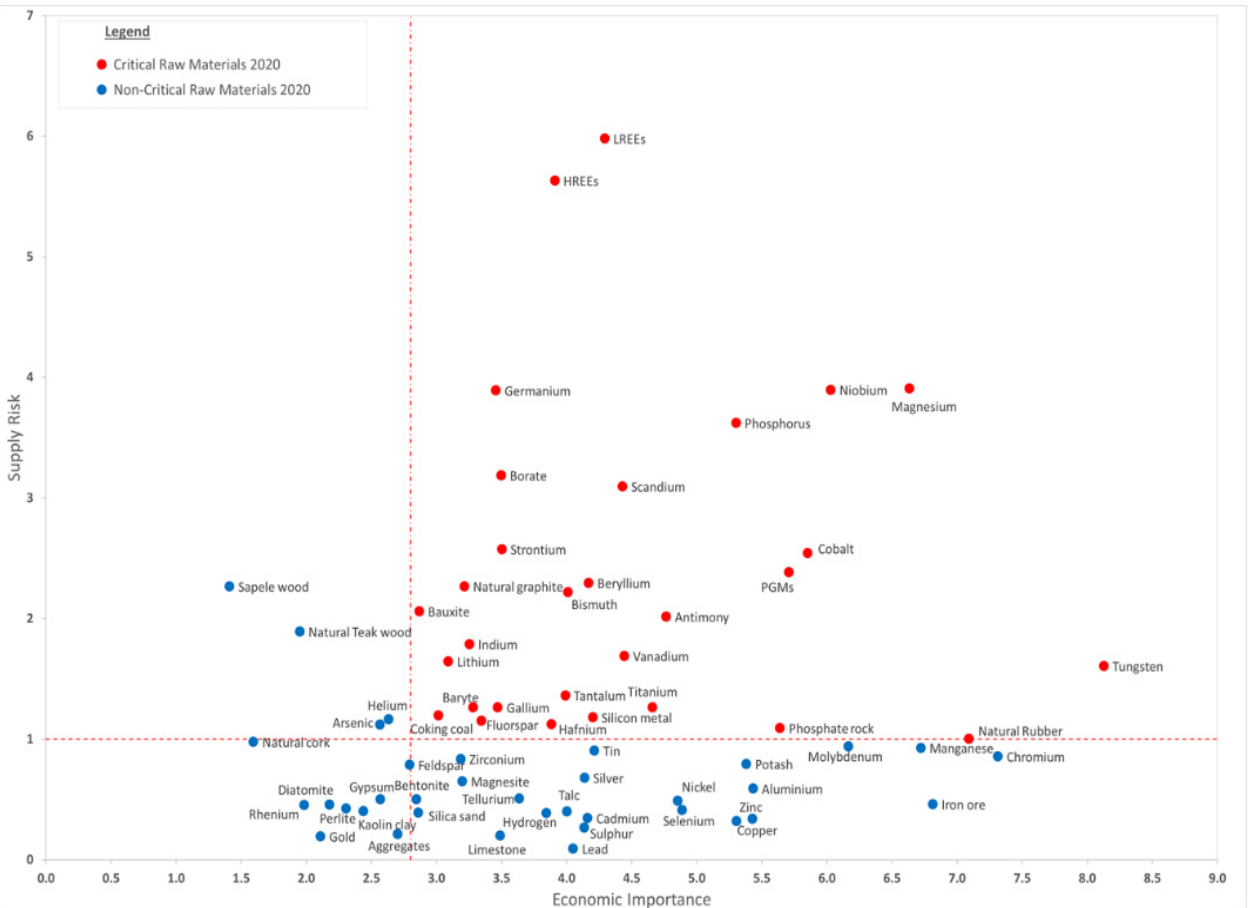
Figure 1. Critical Raw Materials (CRMs) chart based on the 2020 CRM list. Reprinted from [3] Copyright from European Commission. LREEs and HREEs stand for light and heavy rare earth elements (REEs), respectively.